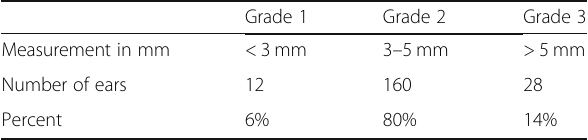
Table 2 STR length (anterior-posterior depth) grading